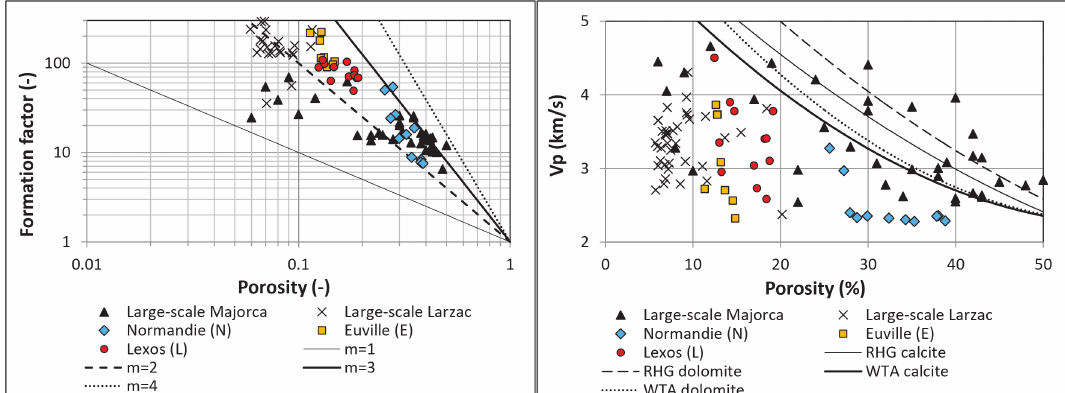
Figure 13. On the left : evolution of formation factor depending on porosity; On the right : evolution of P waves velocities depending on porosity (modified from